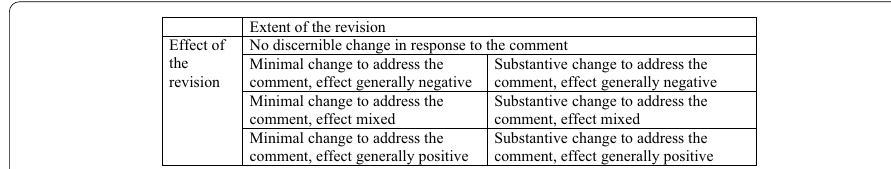
Fig. 1 Rating scale for content and form end comment revisions, adapted from Ferris